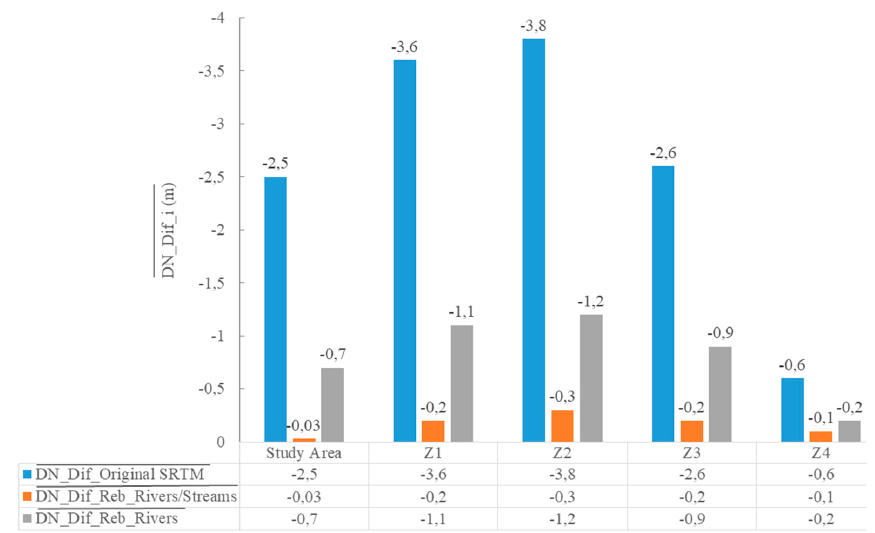
Figure 21. Graph showing the mean vertical distance between the elevations of the drainage networks extracted from the reference and the original SRTM 30, and the rebuilt DEM using OSM rivers and streams, and only OSM rivers.